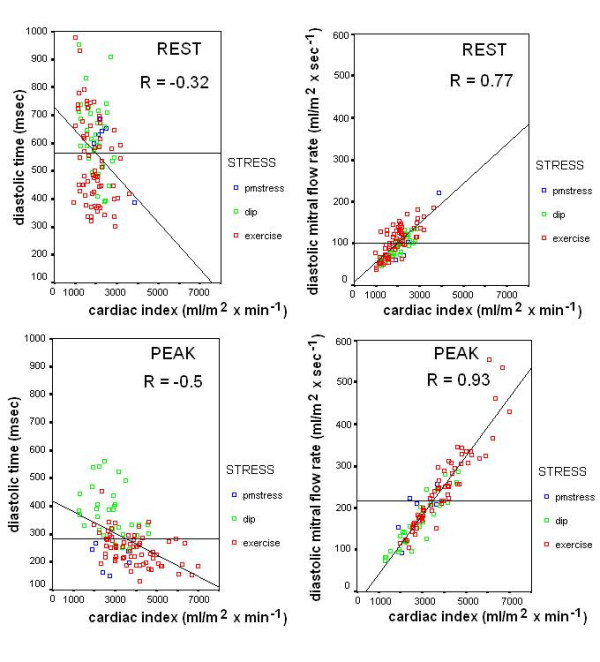
Diastolic time and diastolic filling rate vs. cardiac index: summary data. Left panels: scatter plots demonstrating relationships between the diastolic duration time and the cardiac index, both at rest and at peak stress. Right panels: scatter plots demonstrating relationships between the diastolic filling rate and the cardiac index, both at rest and at peak stress. Green symbols: dipyridamole stress; blue symbols: pacing stress; red symbols: exercise stress. The substantial increase in the LV diastolic filling rate measured as volume per time suggests a large filling capacity during exercise (red symbols).